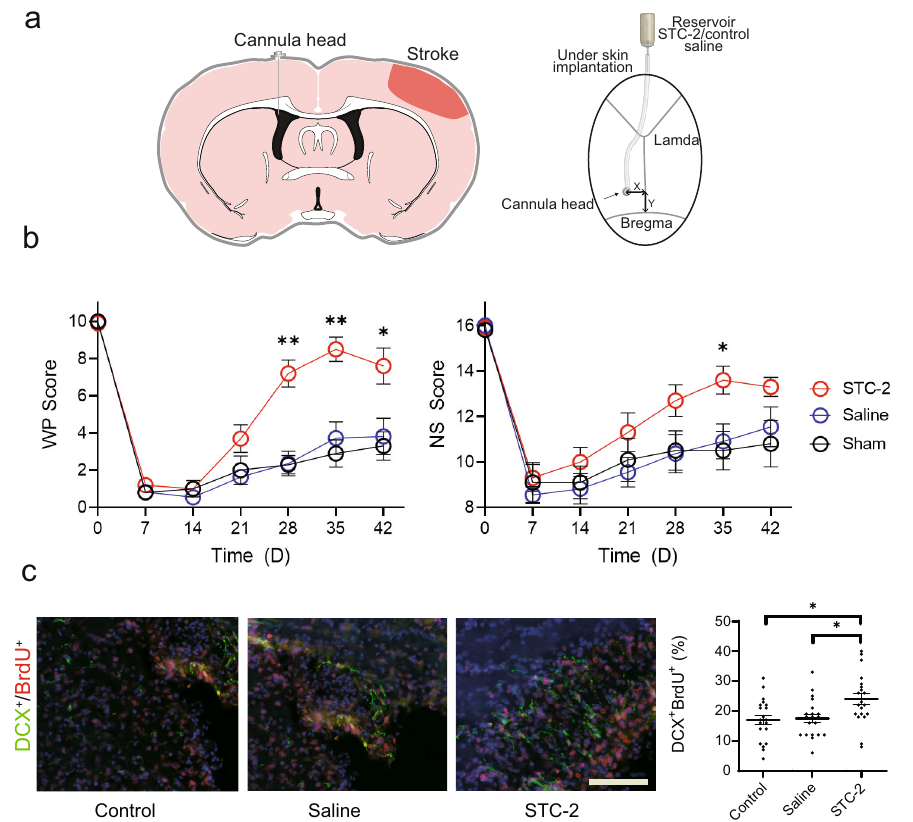
Fig. 5 Intraventricular delivery of recombinant STC2 protein in rodents. a Schematic of the brain slice view (left) and top view (right) in the skull for STC2 protein delivery via mini-osmotic pump. The cannula of the osmotic pump is implanted at 0.8mm posterior (Y) and 1.5mm contralateral (X) to the bregma at a depth of 3.5mm at 1-week after stroke. b Behavioral testing. Vibrissae-forepaw (WP) behavioral testing (left) and overall neurological score (right). Based on WP, STC2 group exhibited statistically signi fi cantly greater recovery beginning at 4 weeks post-stroke compared to other groups. c Endogenous neuroblasts. Representative images of DCX + /BrdU + cells (left) and the cell count of number co-positive cells (right) at peri-infarct region. b Analyzed using a log-transform two-way repeated measures ANOVA which revealed a statistically signi fi cant interaction between the effects of treatment group and WP Score ( F [12, 162] = 7.058, P < 0.0001); followed by Dunnett ’ s multiple comparisons test. Neurological scores (NS) were analyzed using a Kruskal – Wallis test ( P = 0.018), followed by Dunn ’ s multiple comparisons test. For both, * P < 0.05, ** P <0.01, data shown as mean± SEM, n = 10 per group. c Analyzed using one-way ANOVA, followed by Tukey ’ s HSD post-hoc test with * P < 0.05. Data shown as mean± SEM, n = 20 images/4